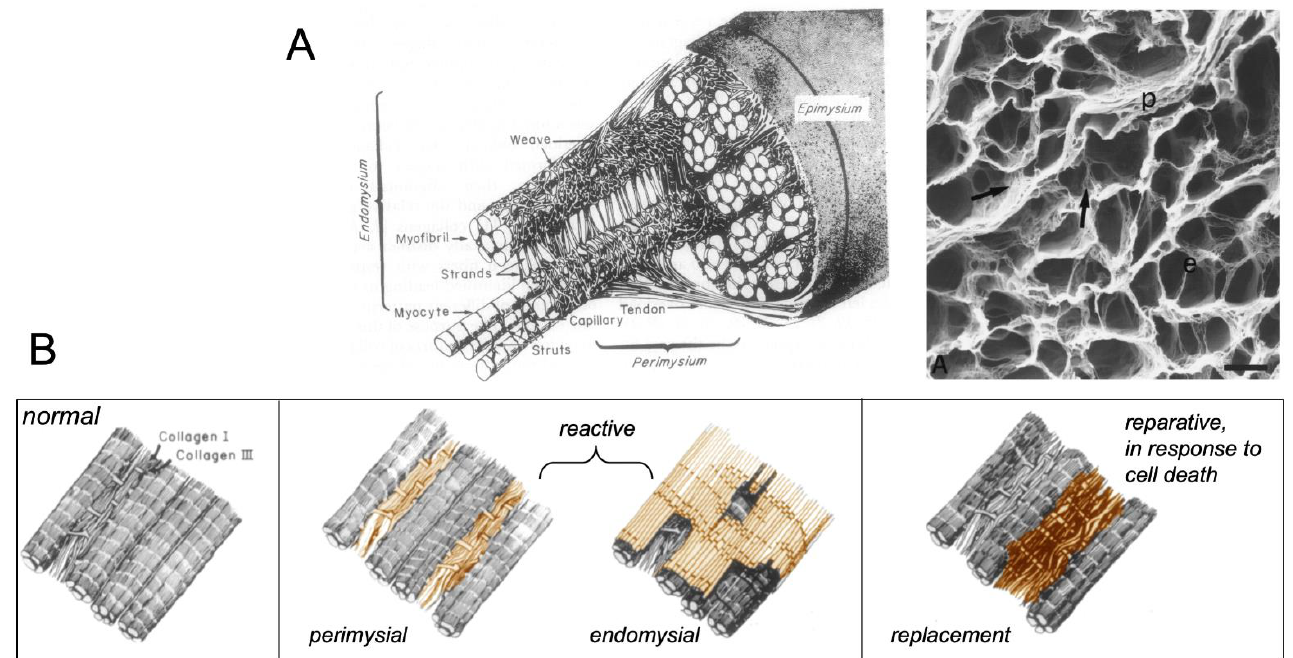
Figure 1. Fibrous skeleton of the heart and patterns of fibrosis. ( A ) Schematic illustration of the normal collagen matrix, illustrating perimysial fibrous tissue enveloping myocyte bundles and endomysial fibrous tissue in between strands of myocytes within bundles (left panel). Acellular preparation after digestion of cells showing perimysial sheets (p) and endomysial septae (e). ( B ) Schematic representation of the normal ECM (left panel), endomysial and perimysial fibrosis (middle panel), also called reactive fibrosis, and replacement/ reparative fibrosis secondary to myocyte death (right panel), adapted from [1].